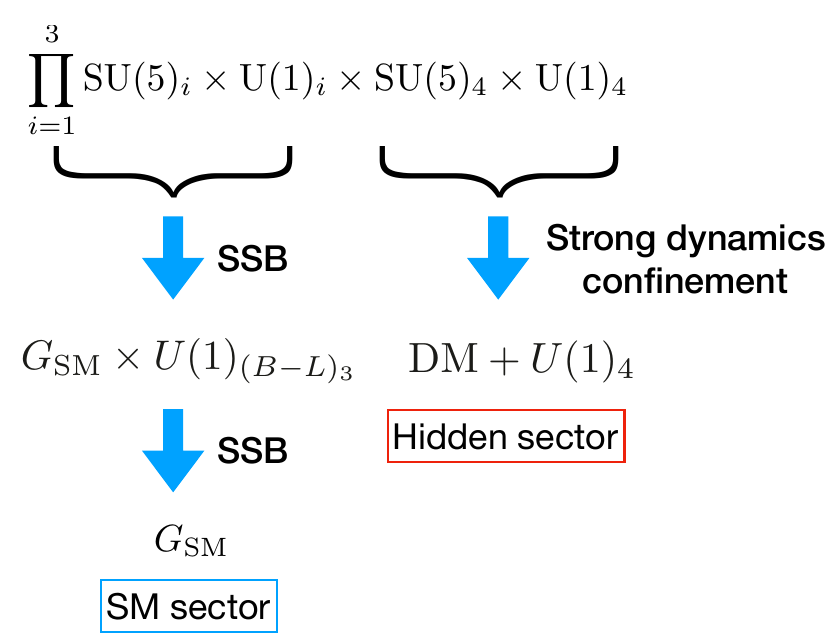
Figure 1 . Gauge symmetry breaking pattern in our uni(cid:12)ed model. The SM gauge group is denoted as G SM = SU(3) c SU(2) L U(1) Y (cid:2) (cid:2)